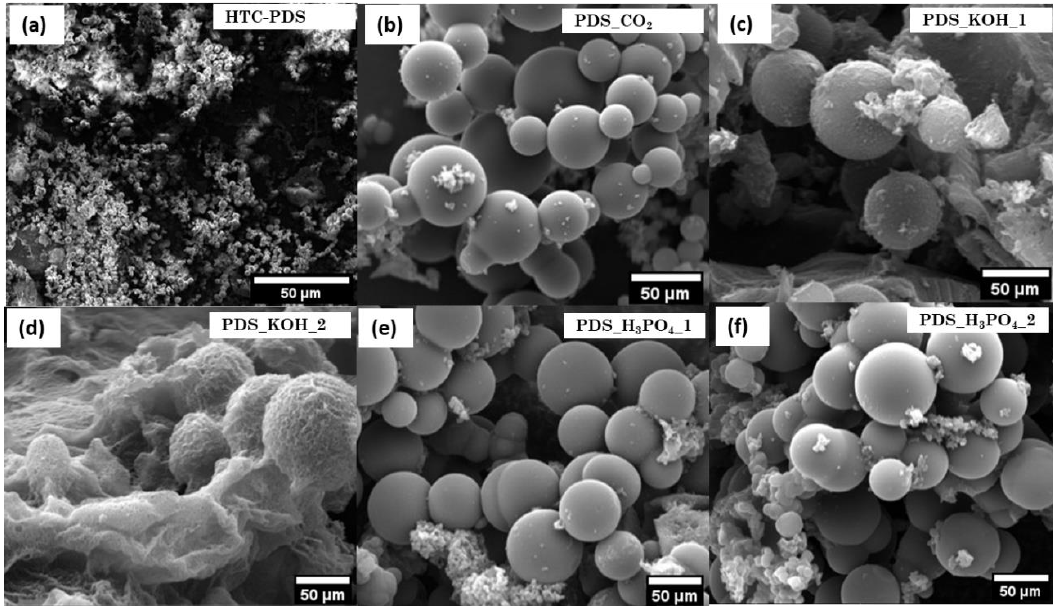
Figure 1. SEM images of the ( a ) HTC-PDS and ( b – f ) the corresponding activated materials. Apart from the morphology, it is critical to understand how the carbon lattice is structured in these particulate powders. In this respect, Raman spectroscopy is a powerful analytical tool for studying the lattice structure of carbon materials. In Figure 2, the different spectra of the activated powders reflect some common features. First, the two characteristic bands of graphitic carbons were centred at 1338 cm − 1 (D band) and 1585 cm − 1 (G band) [32]. Throughout the samples, there were no meaningful shifts in the wavenumbers of these bands (Table S1), with the exception of HTC-PDS_KOH_1 (D band = 1329 cm − 1 and G band = 1564 cm − 1 ). Their intensity ratio ( I D / I G ) and band overlap were used to infer the density of lattice defects. Generally, the ratio increased slightly when a higher concentration of the oxidiser was used (on the KOH and H 3 PO 4 samples). The band overlap was similar, apart from the sample HTC-PDS_KOH_1, where the separation was more visible, as its bands had reduced widths. Furthermore, both KOH-activated powders had a visible 2D peak at ca. 2658 cm − 1 . The Raman analysis confirmed that the CO 2 and H 3 PO 4 activations produced similar carbon materials (in regards to morphology and structure). By contrast, wet impregnation with the hydroxide leads to a better volumetric structural ordering (stacking of graphene layers), particularly for the sample HTC-PDS_KOH_1, where the 2D is quite noticeable. On the whole, the surface roughness and structural order differ in the two HTC-PDS_KOH samples, with the smoother surface HTC-PDS_KOH_1 showing a higher graphitization degree.